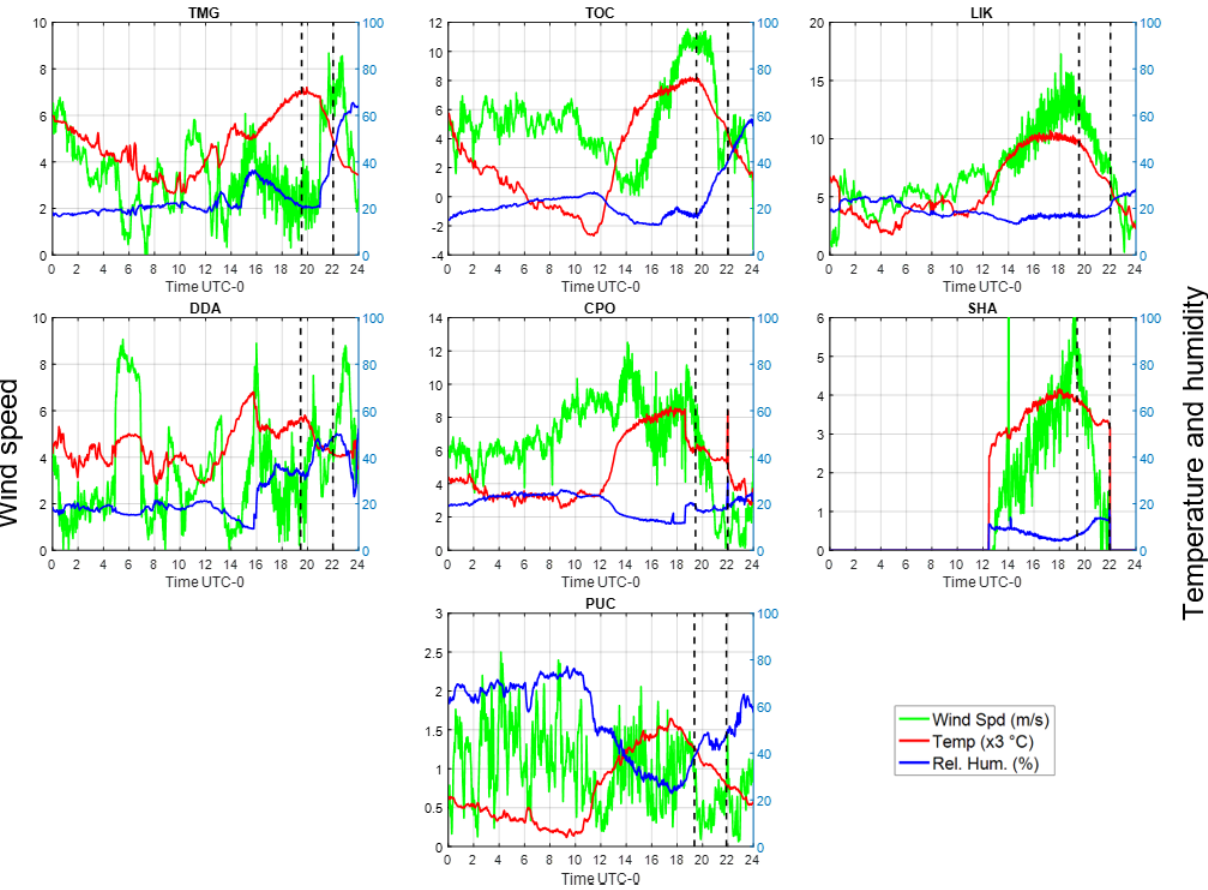
Figure 10. Meteorological variables for 2 July 2019 at the measurement stations: wind speed, ambient temperature, and relative humidity. Ambient temperature is displayed with a scaling factor of ×3. Dashed vertical lines show the beginning and end of the eclipse according to astronomical algorithm.